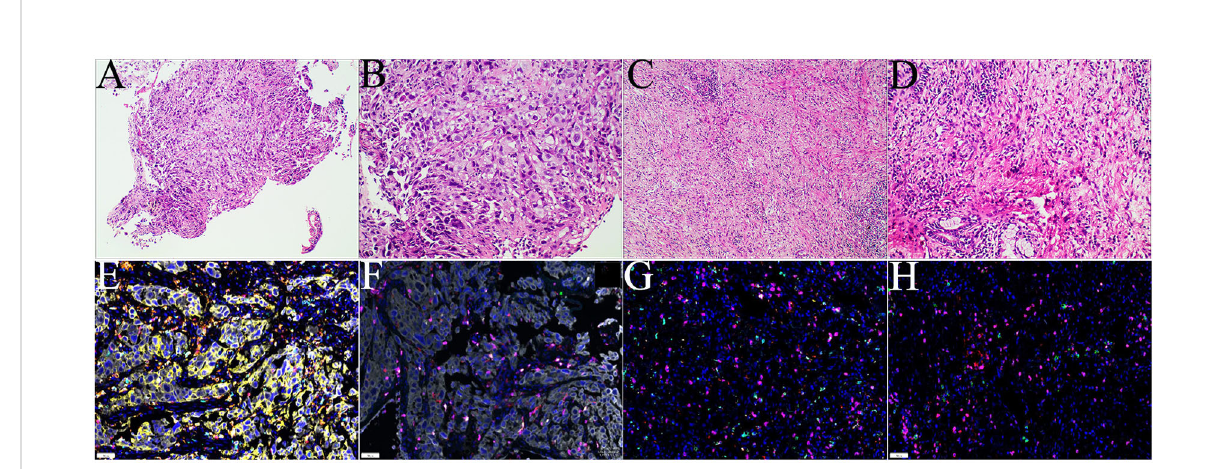
FIGURE 3 Examinations of pathology and mIHC. (A, B) . Histology of biopsies samples (CT guided biopsy); (C, D) histology of surgical tissue sample; (E, F) mIHC staining of tumor microenvironment of puncture tissue; (G, H) mIHC staining of tumor microenvironment after operation.